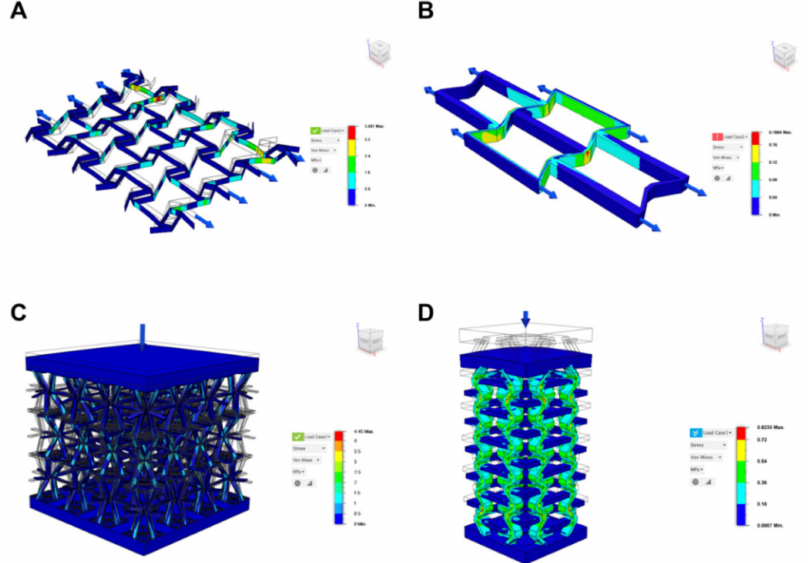
Figure 2. Examples of computational modelling applied to auxetic metamaterials. FEM modelling of displacements of auxetic cells under quasi-static loading. ( A , B ) Two-dimensional lattice structure based on re-entrant cell. ( C , D ) Three-dimensional auxetic based on re-entrant cells. Computational modelling was performed using Fusion Autodesk 360 (Santa Monica, CA, USA) software specifically for the